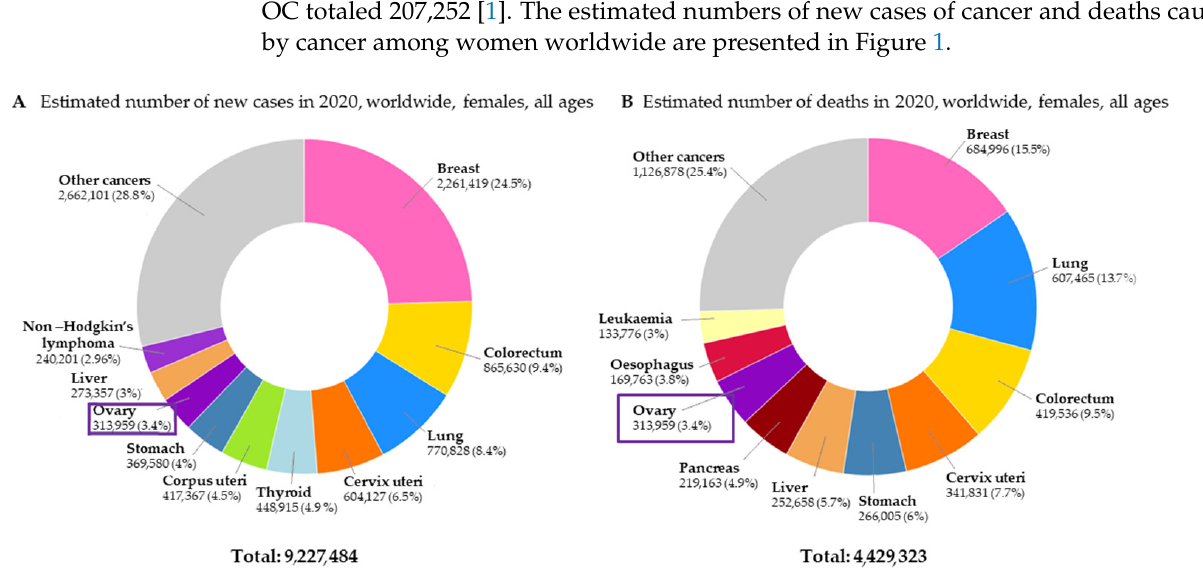
Figure 1. The estimated number of new cases of cancer ( A ) and deaths caused by cancer ( B ) among women worldwide [1].